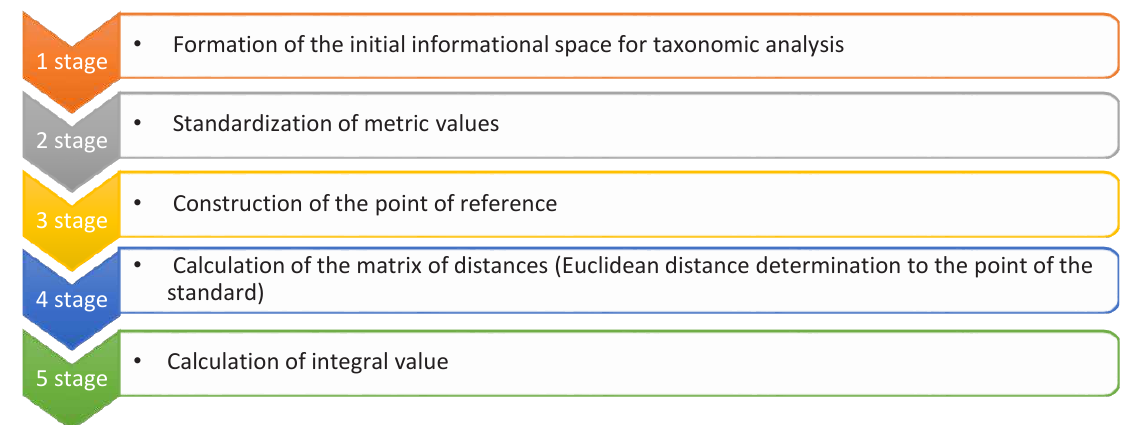
Figure 2. Algorithmic model of the integral index